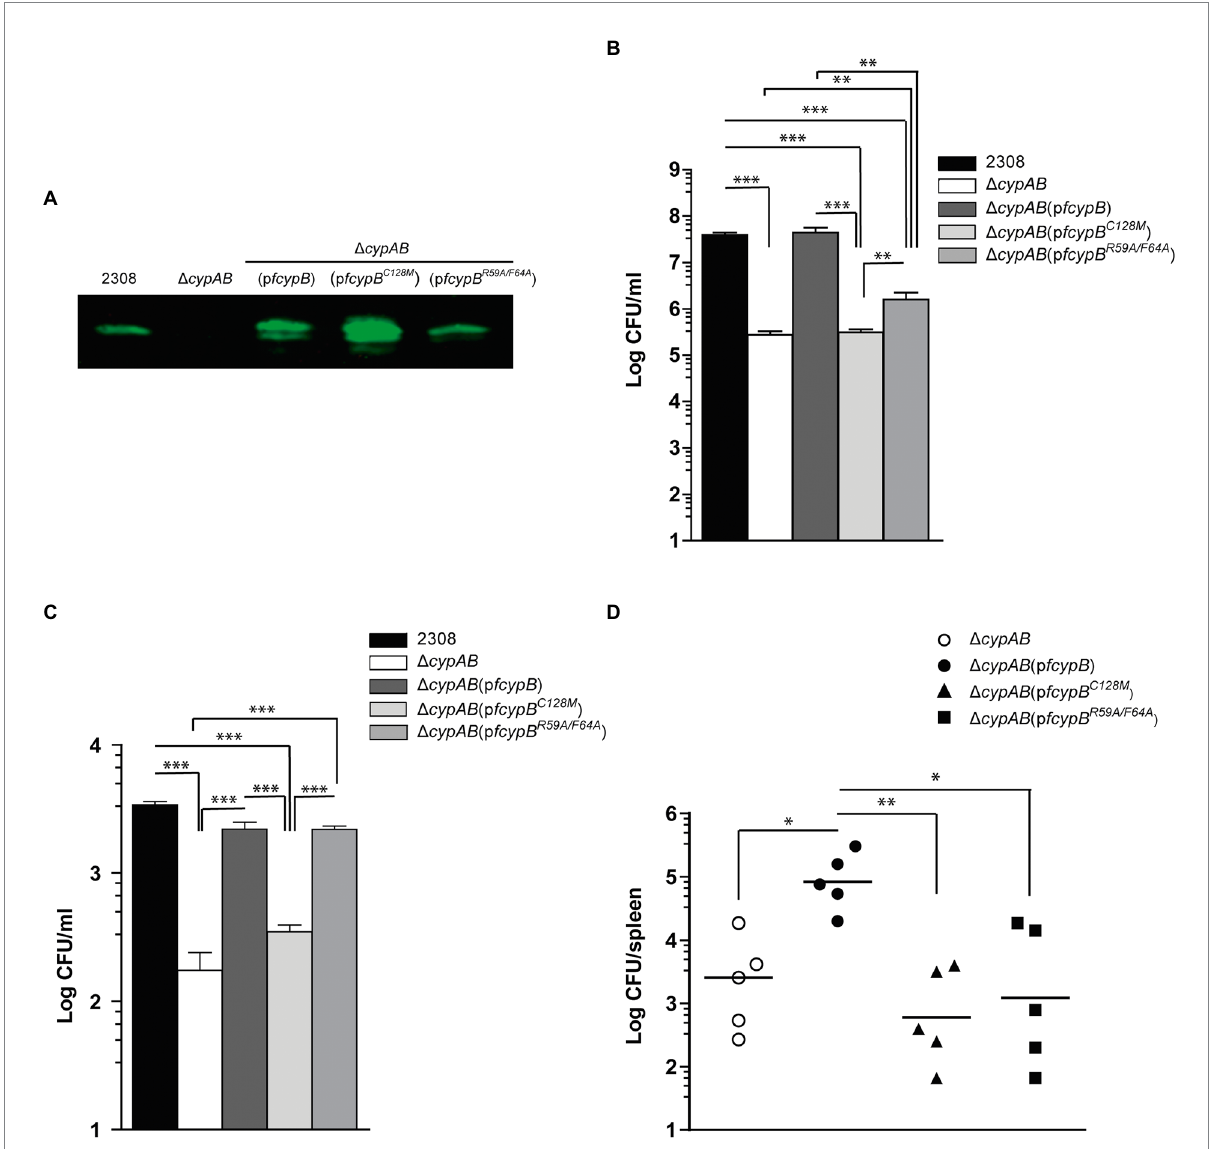
FIGURE 8 Dimeric form of CypB is required for survival and virulence of B. abortus. (A) Western blot analysis of whole-cell lysates of B. abortus strains expressing wild-type CypB, the monomeric form CypB C128M , and the active site mutant CypB R59A/F64A detected by a mouse antibody against CypB. (B) Detergent sensitivity assay using serial dilutions of different B. abortus strains plated in triplicate onto TSB agar plates containing deoxycholate (DOC) (1,000 μ g/ml). Plates were incubated for 72 h, and the number of CFU was scored. (C) Intracellular survival of the B. abortus strains in HeLa cells. Numbers of CFU of intracellular bacteria were determined after lysis of infected cells at 4 h post-infection. Each determination was performed in triplicate, and values are shown as the mean with its respective standard deviation and are representative of three